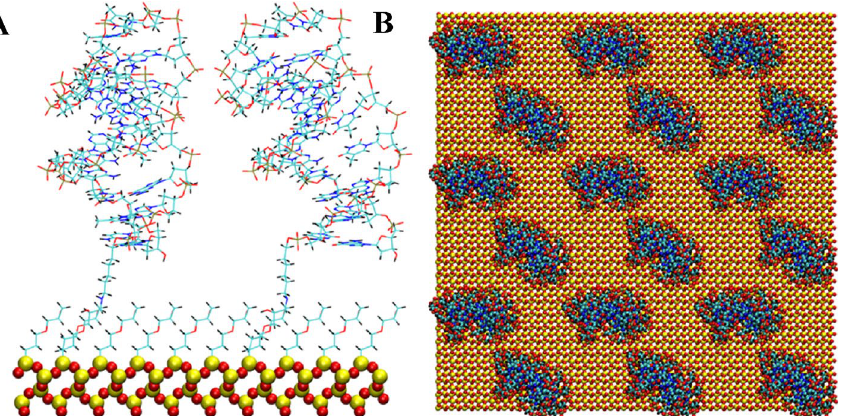
Figure 4. Two anti MUC1 aptamers tethered to SiO 2 biosensor substrate in configuration 3 (5 ′ end attachment, perpendicular to surface, high density). ( A ) Side view of simulation cell ( B ) Top view with periodic display. Water and ion molecules are not displayed.